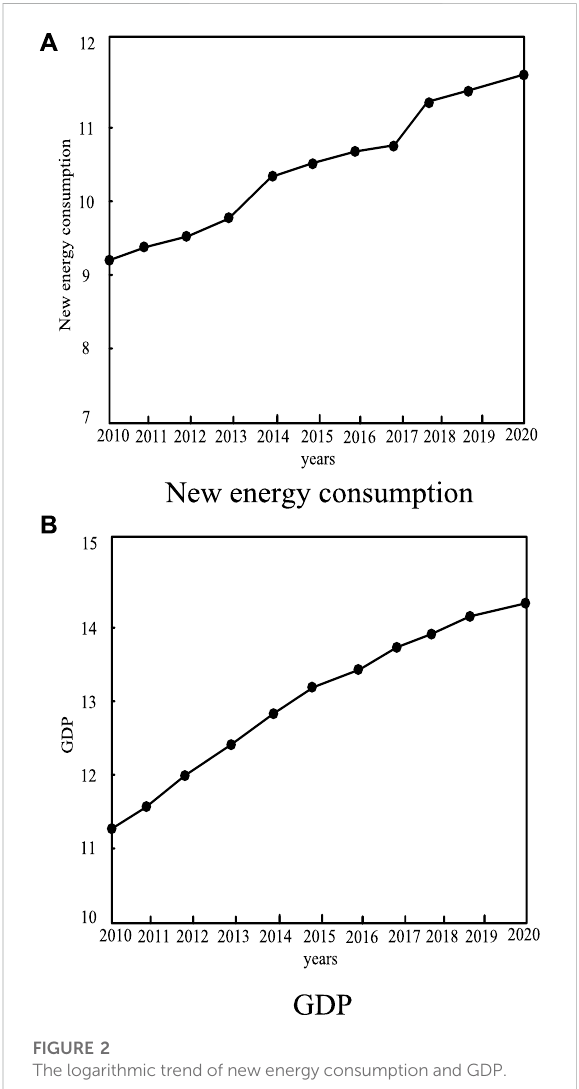
FIGURE 2 The logarithmic trend of new energy consumption and GDP.